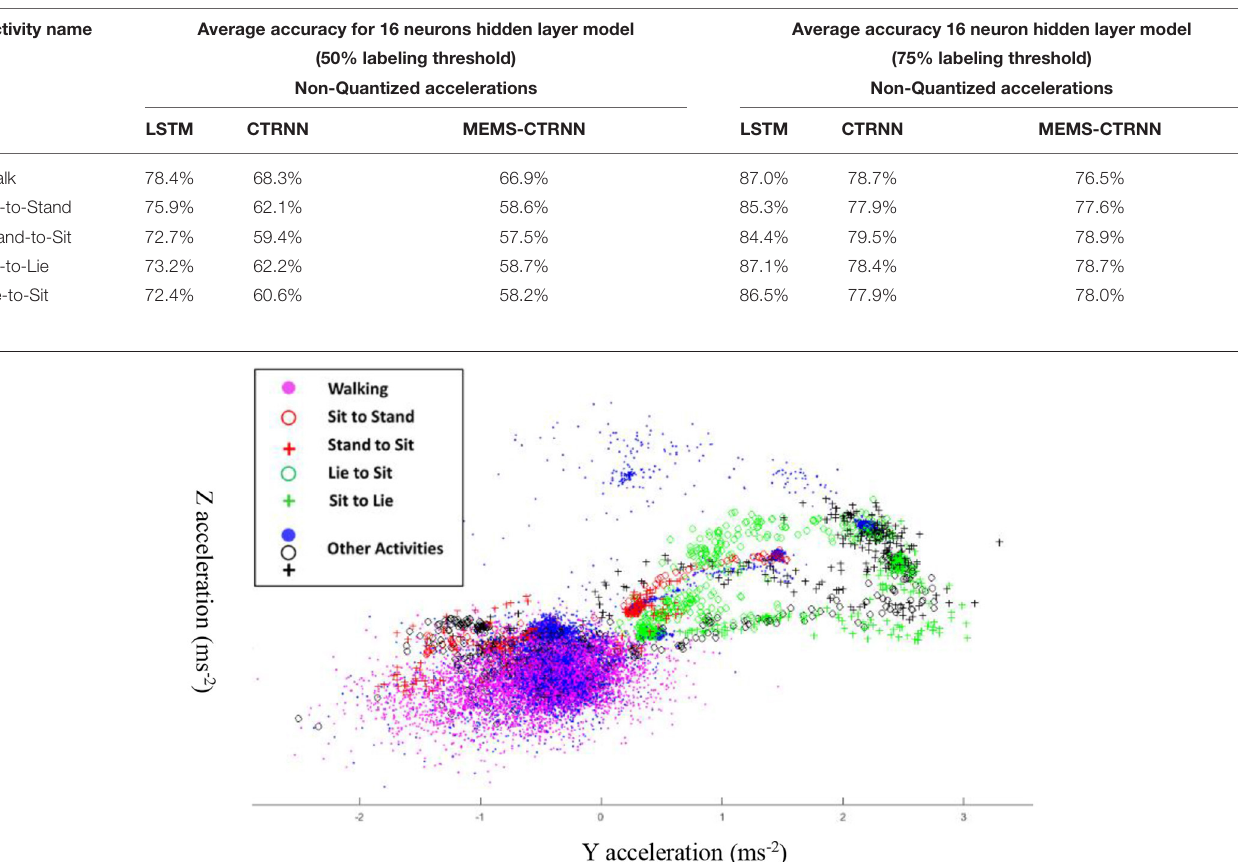
TABLE 5 Impact of changing labeling threshold.